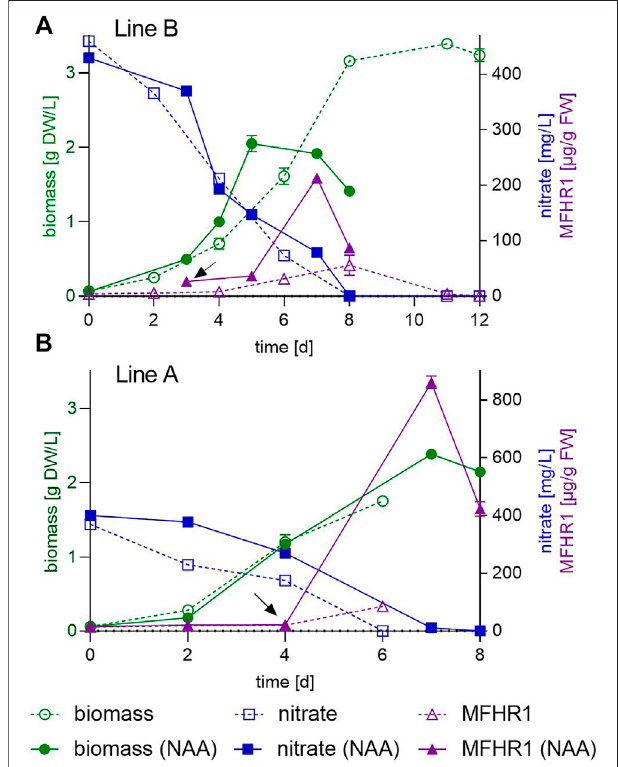
FIGURE 6 | Exogenous auxin enhanced recombinant protein speci fi c productivity in 5 L bioreactor operated in batch. Comparison of biomass, nitrate consumptionand MFHR1 concentration between batch bioreactor run with (full lines) and without exogenous NAA addition (dashed lines). NAA (10 µM) was added at day 3 (A) or 4 (B) . Data represent mean values ±SD fromtwoindependent measurements. ThearrowmarksthetimepointofNAA